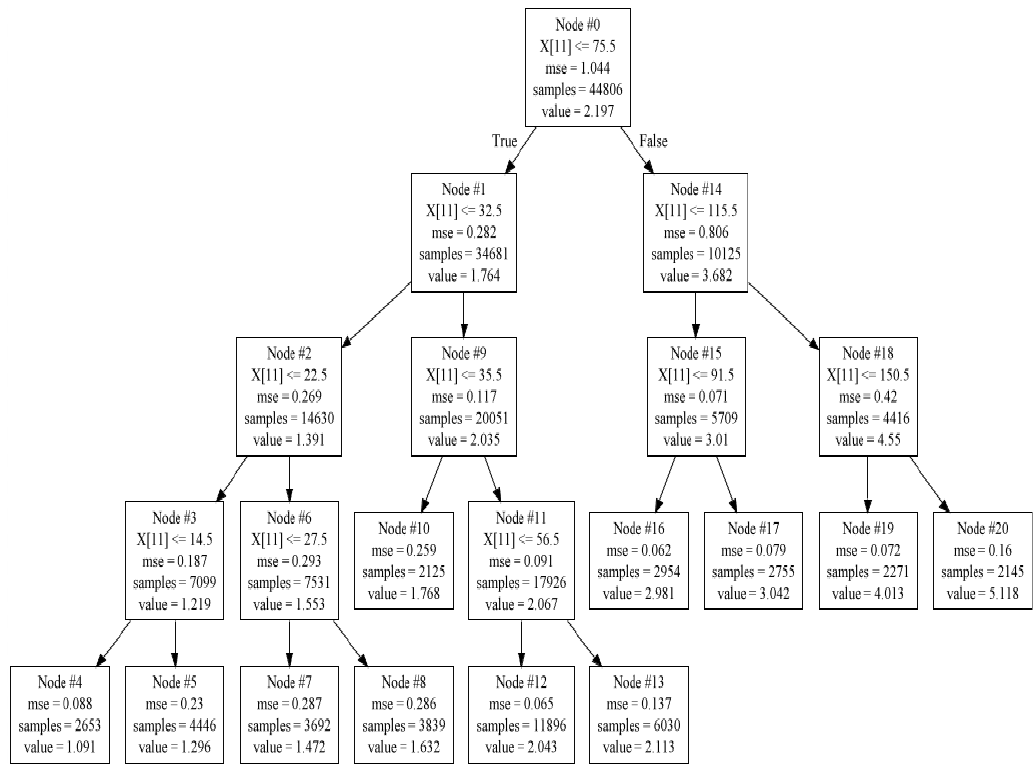
Figure 4. Training results of the CART. The # has no special meaning , and Node #0 represents node 0.